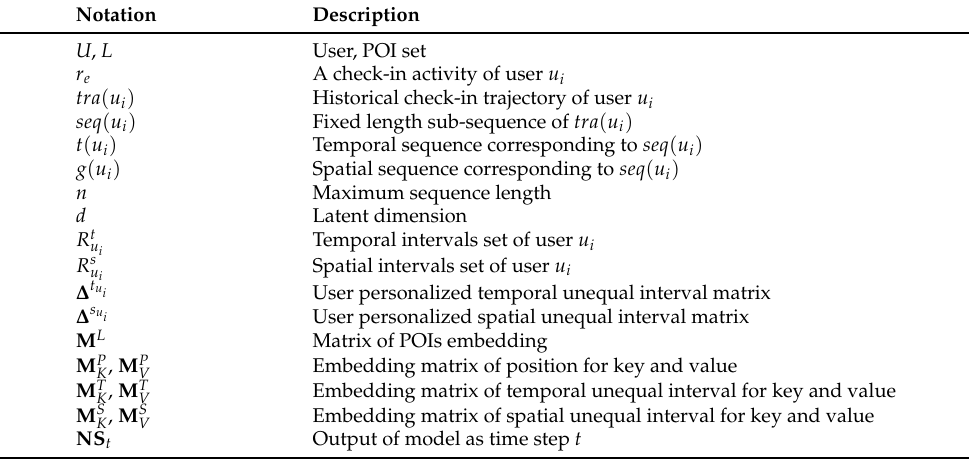
Table 1. Key notations used in this